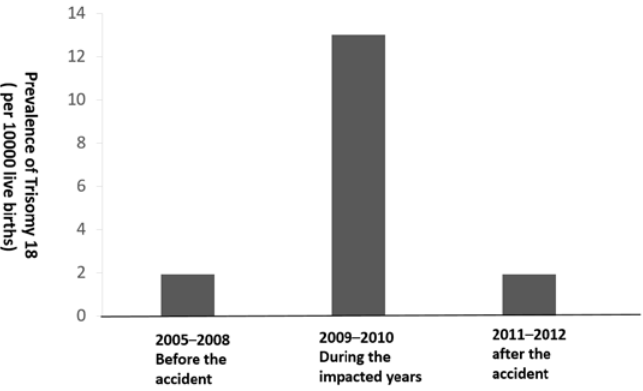
Figure 2. Prevalence of Trisomy 18 before, during, and after the fire accidents in Brazos County, Texas.